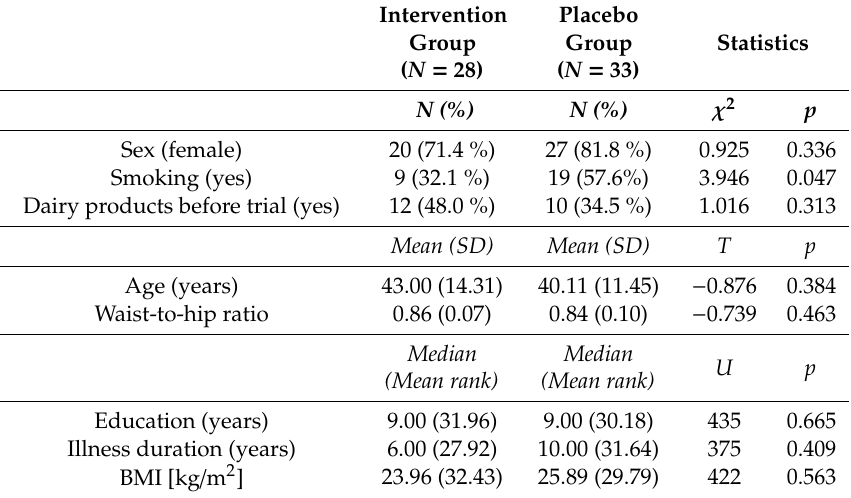
Table 1. Description of the PROVIT sample at baseline. Intervention